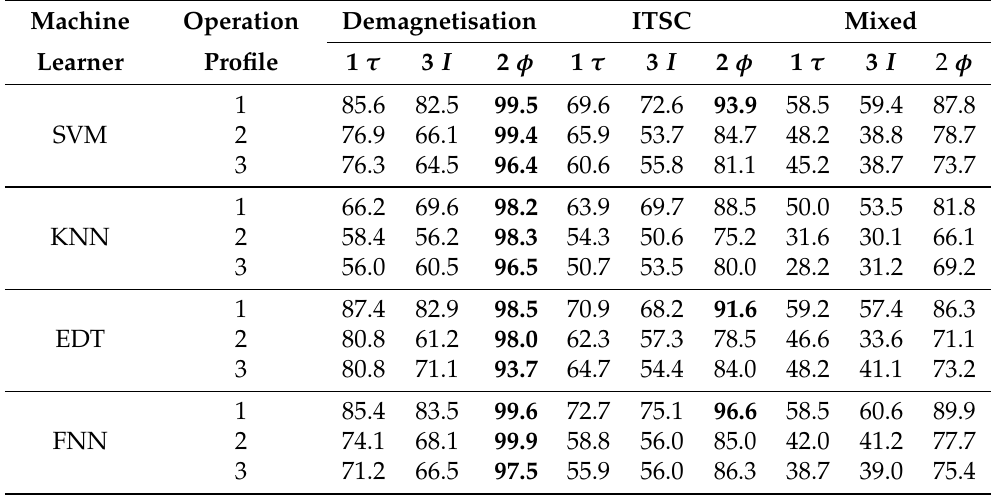
Table 3. Average classification accuracy (%) for detecting demagnetisation, ITSC, and mixed fault case.